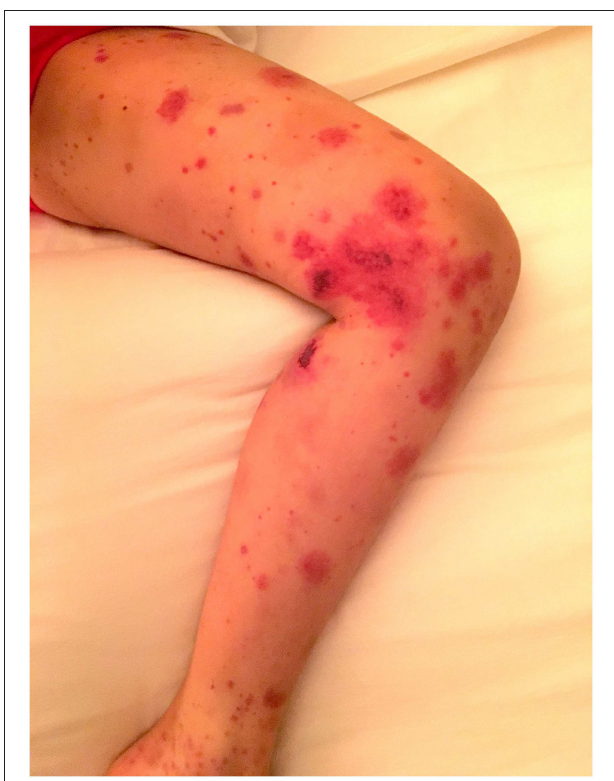
FIGURE 2 | IgA vasculitis presenting in a child illustrating areas of petechiae, purpura, bruising, and necrotic lesions on the limb (parental consent